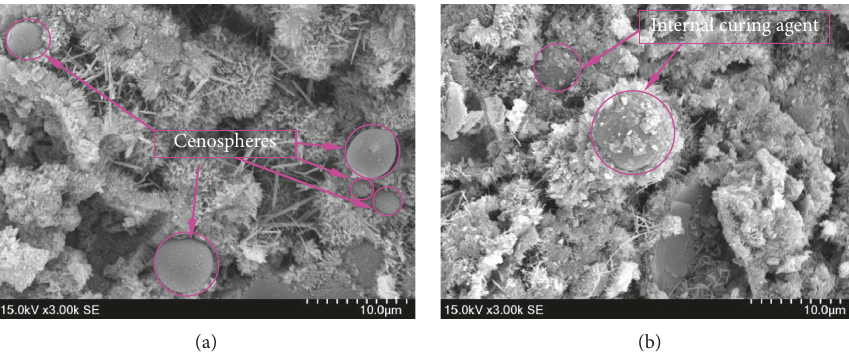
Figure 9: SEM images of the microstructure of foam concrete. (a) Original image of 800-F2. (b) Binarization processing image of 800-E2.